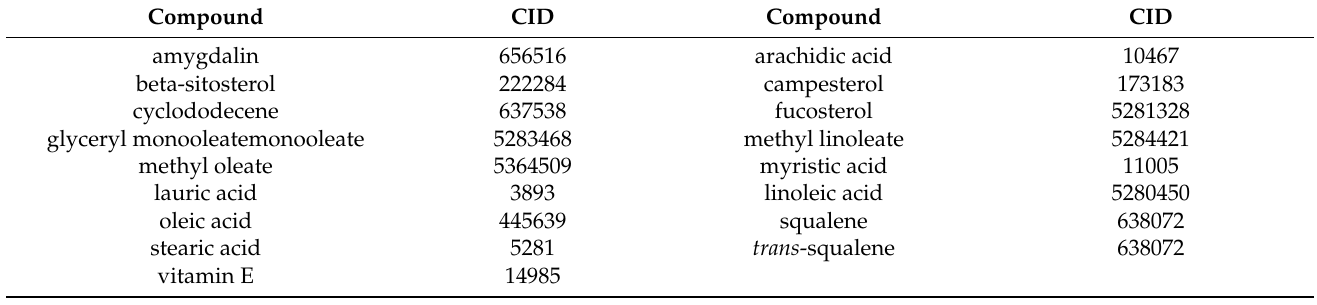
Table 9. Chemical constituents of the kernel of P. mira .